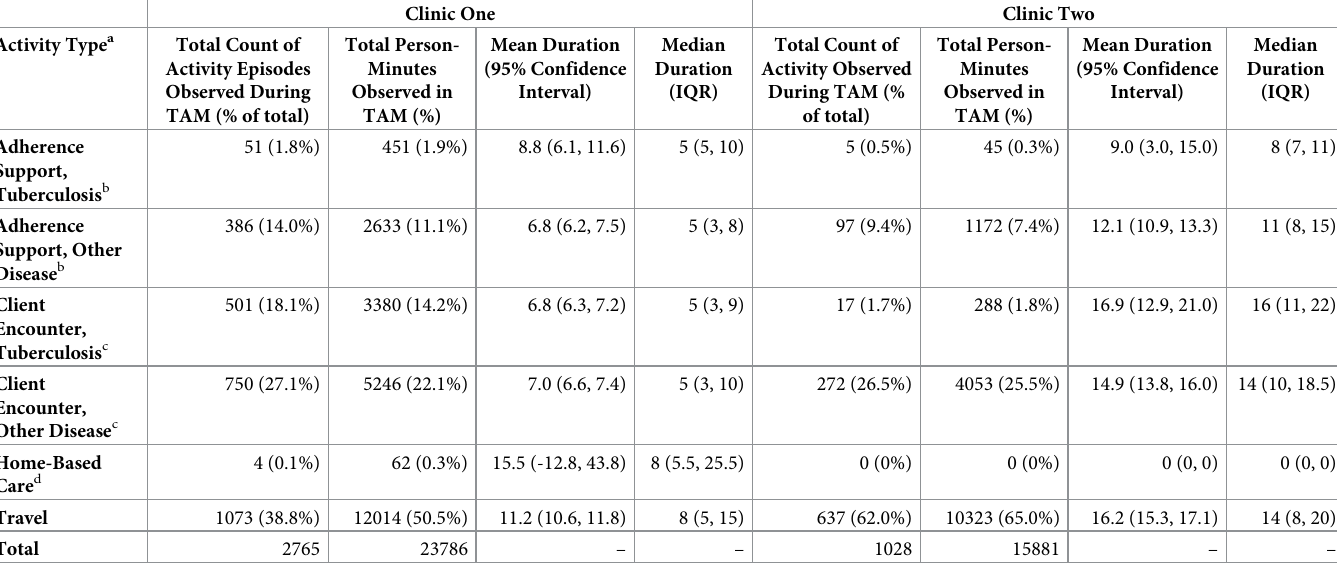
Table 2. Frequency, median duration, and total duration of activity type by